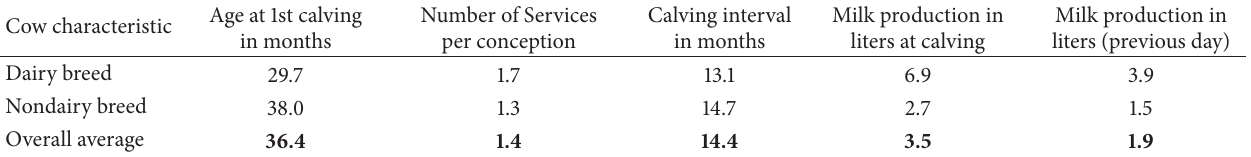
Table 1: Average reproductive performance of dairy and nondairy breed cows in the herds. Cow characteristic